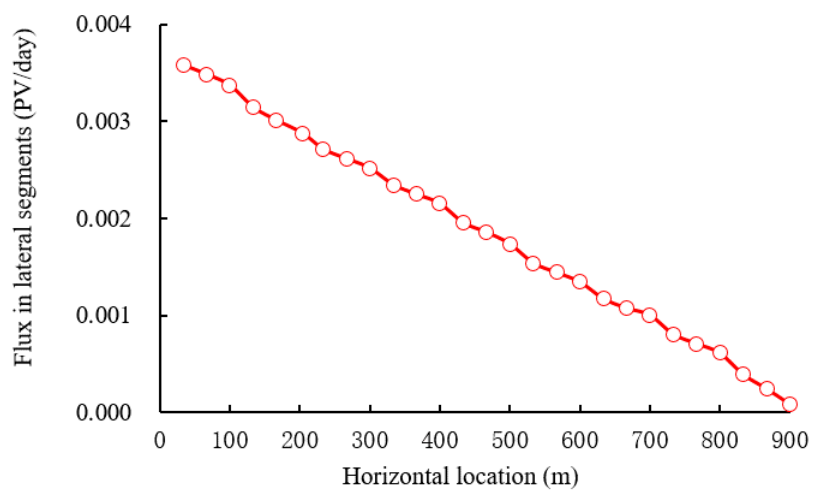
Figure 6. Mass flux distribution of different lateral segments in horizontal well.